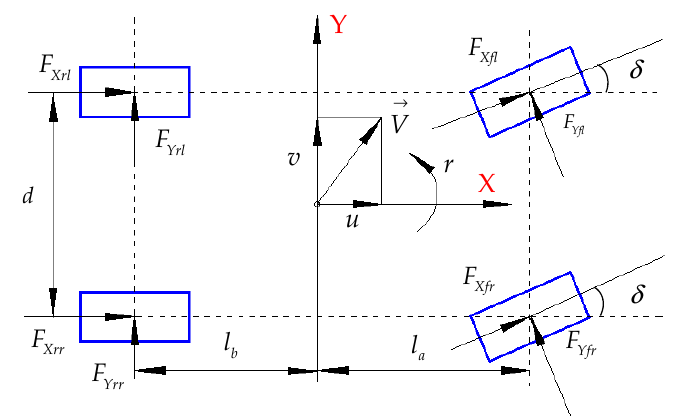
Figure 5. Analysis force of vehicle.